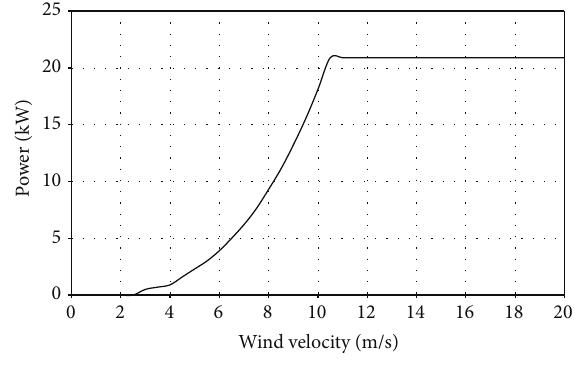
Figure 8: Wind turbine characteristic.